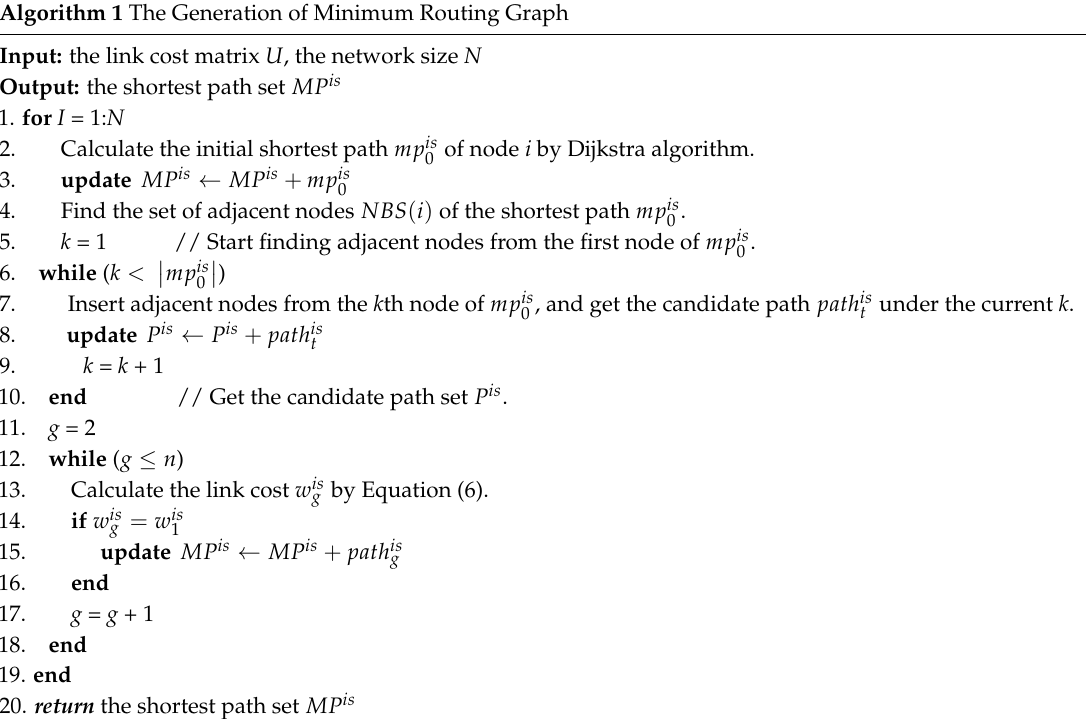
Algorithm 1 The Generation of Minimum Routing